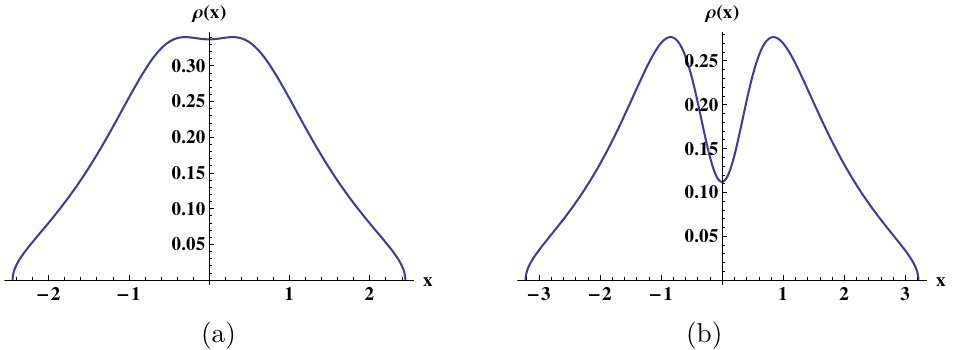
Figure 2 . The eigenvalue density in the one-cut case describing the subcritical regime κ < κ c . (a) τ = 2 , κ = 1 . 5 . (b) τ = 2 , κ = 3 . In this case, the potential has already developed a double-well, but there is an overfilling of eigenvalues, which are still distributed in one cut.